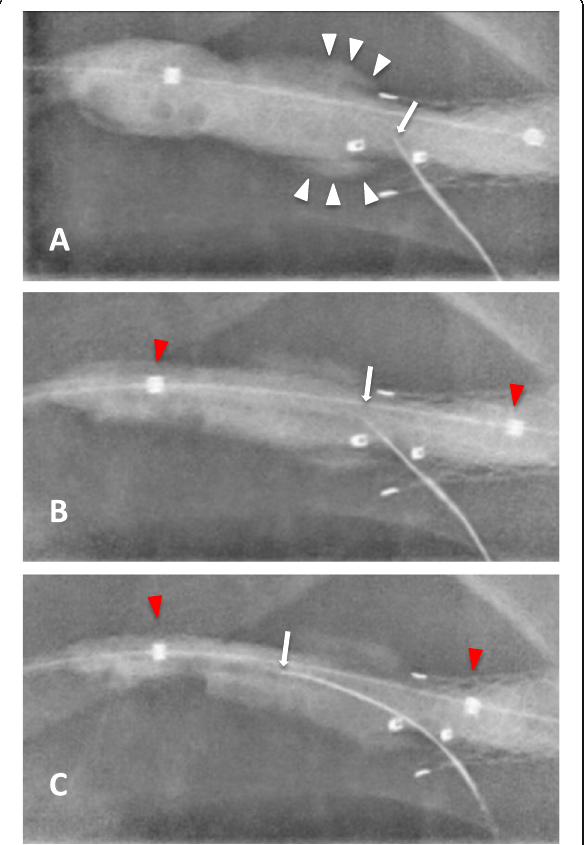
Fig. 5 Sequential fluoroscopic images showing the drilling tip (arrows) of the TruePath device as it punctures the inflated angioplasty balloon within the cephalic arch stent graft with, a rapid deflation of the balloon with contrast spill (white arrowheads) confirming successful entry into the stent lumen. b and c Progressive advancement of the TruePath wire deeper into the balloon with tandem withdrawal of the balloon (red